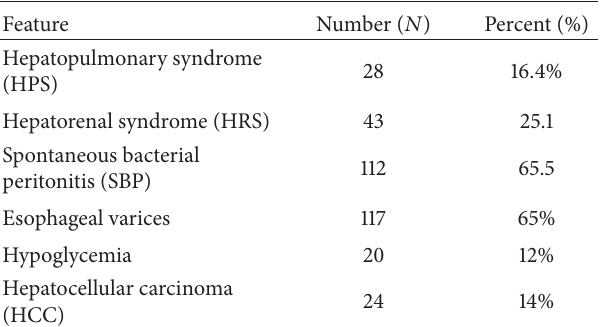
Figure 1: Percentage of patients with different grades of ascites on ultrasonography. Table 3: Number of patients who had developed different compli- cations of chronic liver disease.